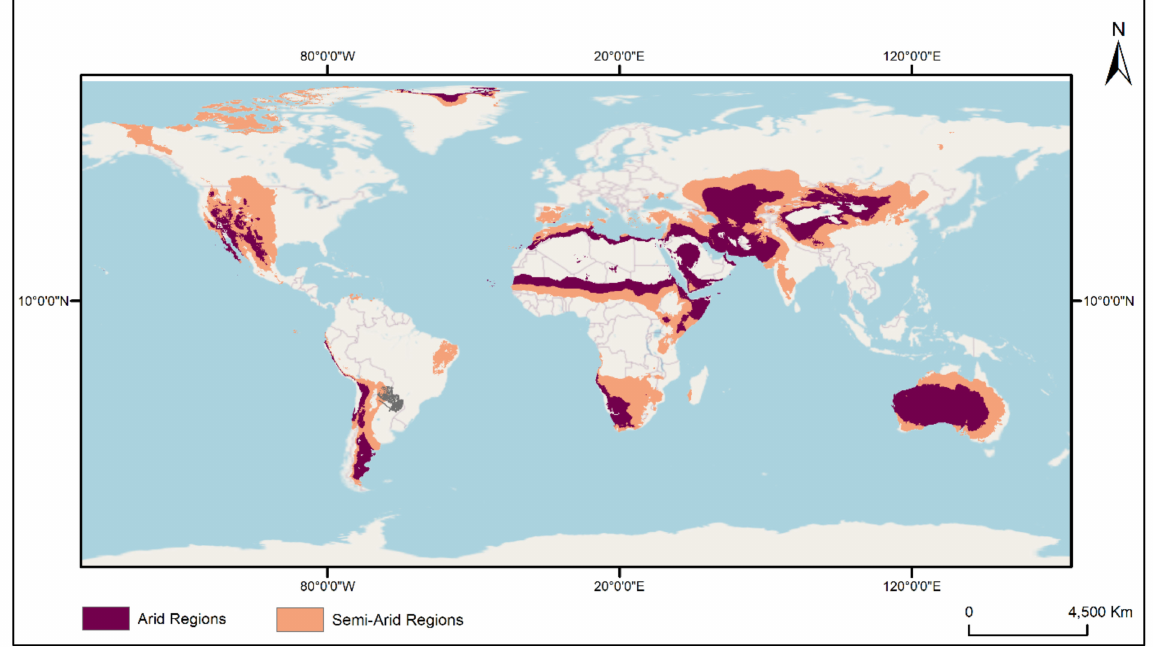
Figure 1. Global distribution of arid and semi-arid (ASA) regions [38]. It is estimated that arid regions cover around 28 million km 2 while semi-arid regions cover around 46 million km 2